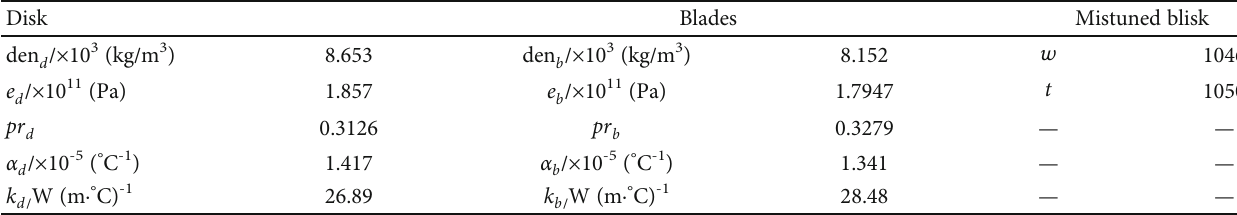
Table 1: Parameters of mistuned turbine bladed